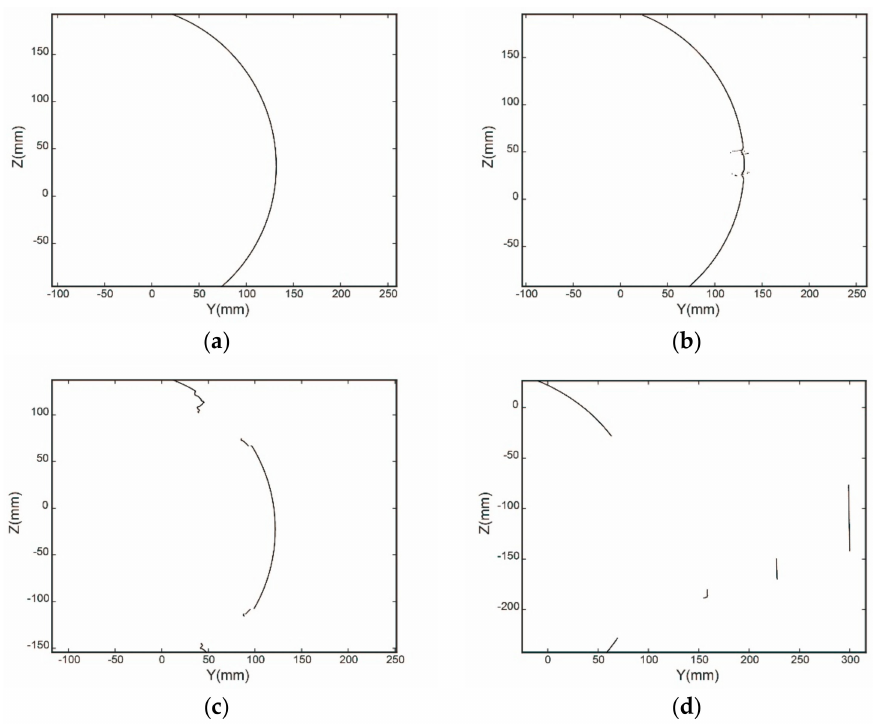
Figure 5. Four acquired ellipse profile point sets from di ff erent areas: ( a ) smooth profile; ( b ) profile through screw holes; ( c ) profile through straight hole; ( d ) profile through